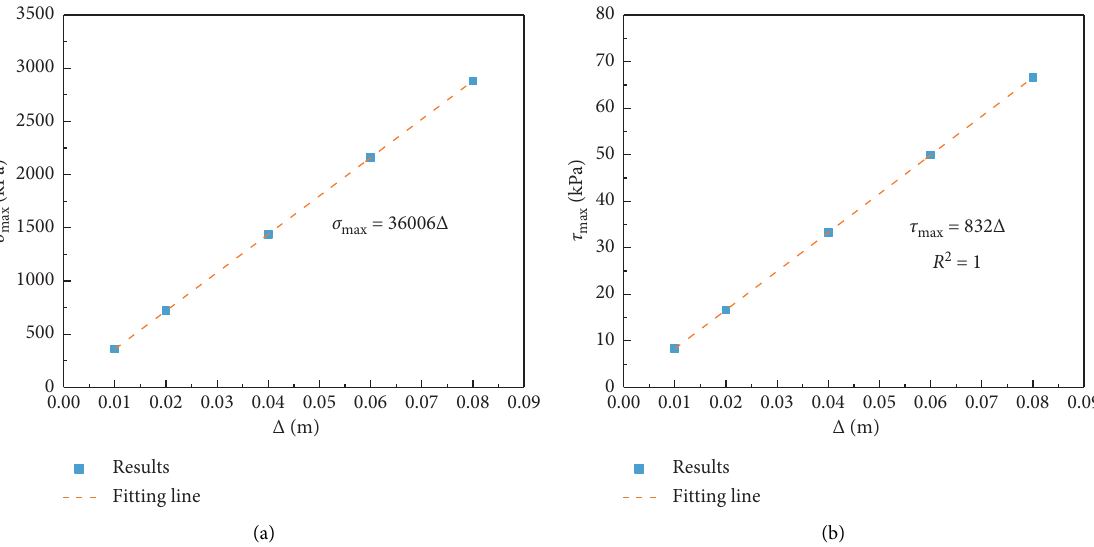
Figure 11: Effects of different frost heave amounts on maximum normal stress (a) and maximum shear stress